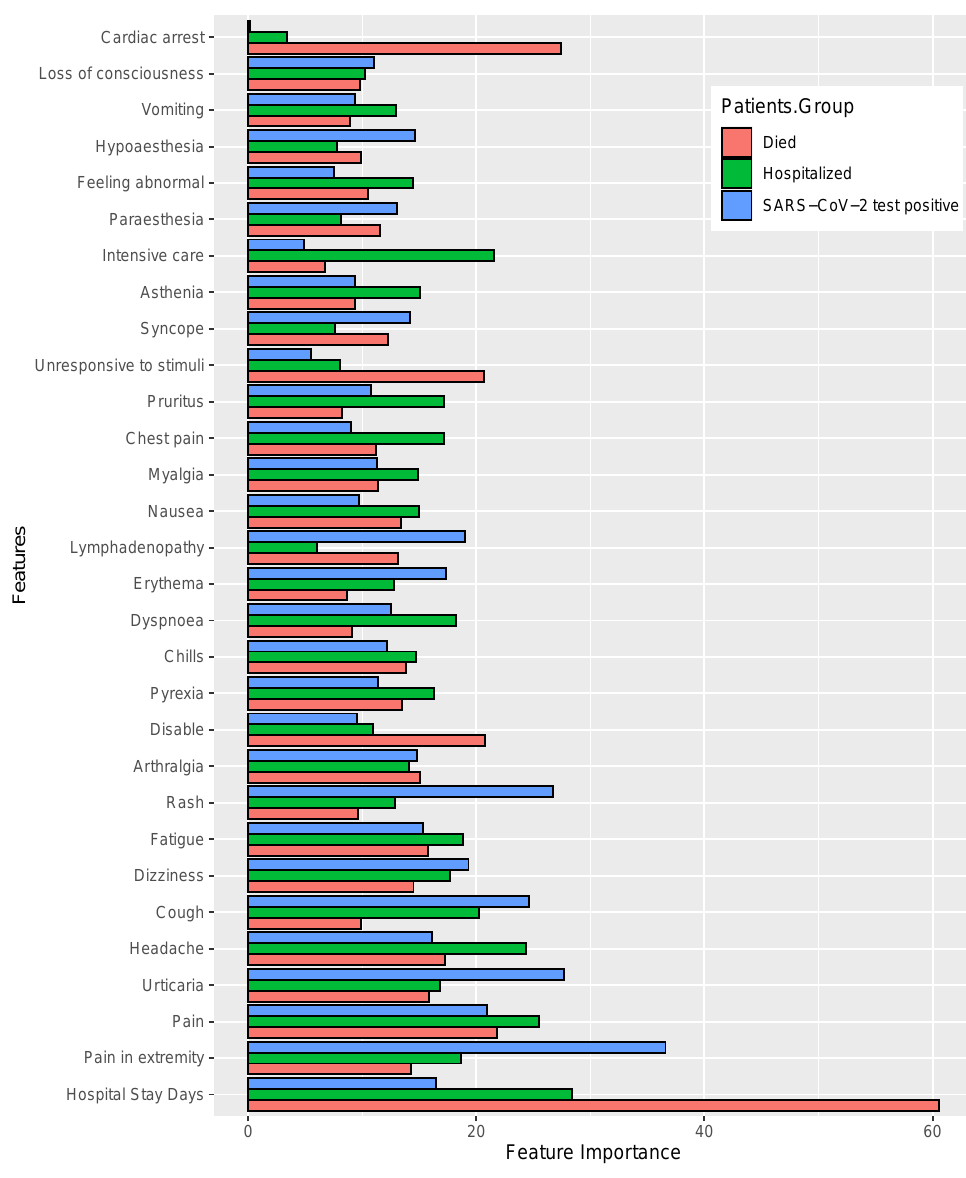
Figure 8. The features ranking according to the coefficient values of the patients’ adverse reactions, calculated after machine learning model training. ML model outcomes indicate that higher coefficient values are mostly close to the significant association of